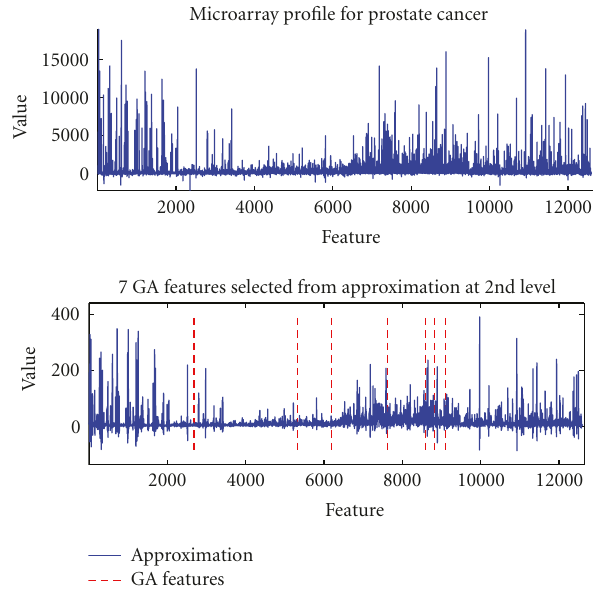
Figure 10: 97.06% performance of selected genes for test samples of prostate cancer dataset.